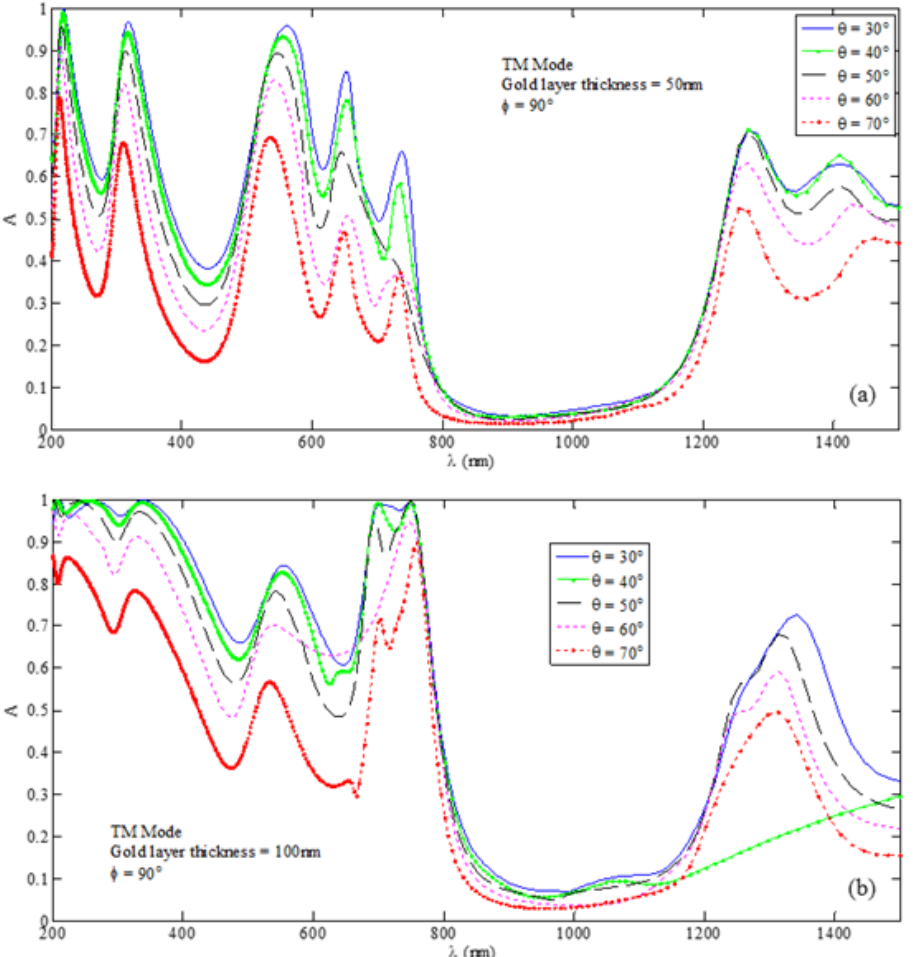
Figure 8. Absorption spectra for the U-shaped MPA nanostructure under the TM wave with ϕ = 90° excitation incidence and corresponding to the cases of ( a ) 𝑑 = 50 nm and ( b ) 𝑑 = 100 nm with 𝑡 = 100 nm.